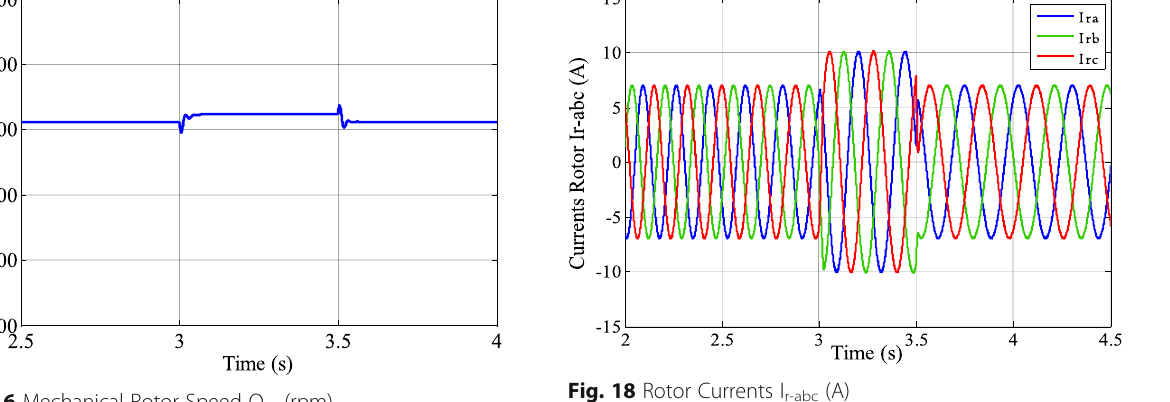
Fig. 16 Mechanical Rotor Speed Ω m (rpm)